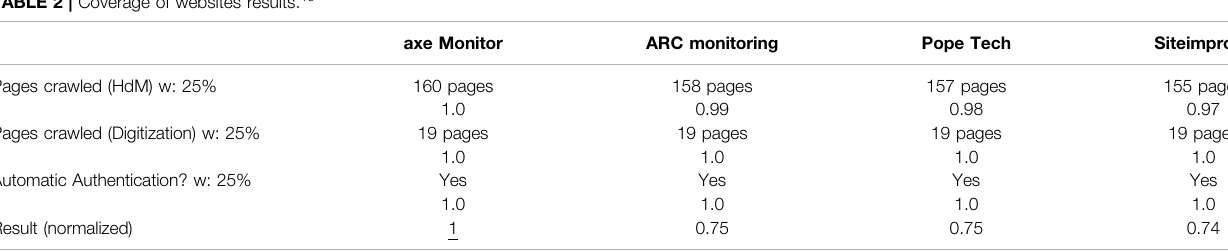
TABLE 2 | Coverage of websites results. 19